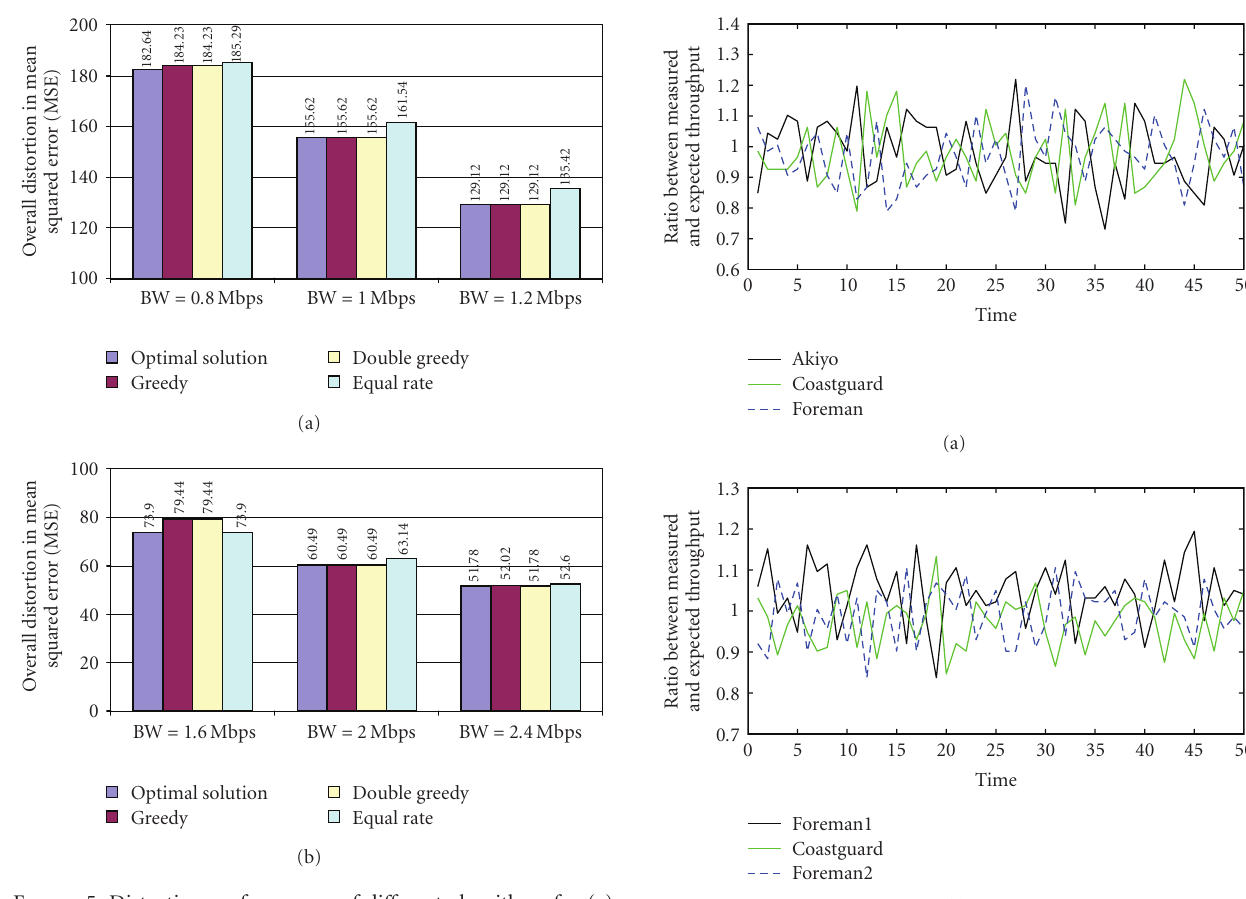
Figure 5: Distortion performances of di ff erent algorithms for (a) video profiles in Table 1, (b) video profiles in Table 2.